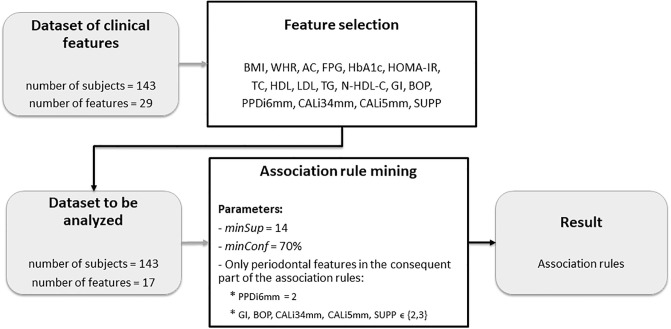
Flowchart that summarizes the process of association rule mining from the dataset containing solely clinical features.